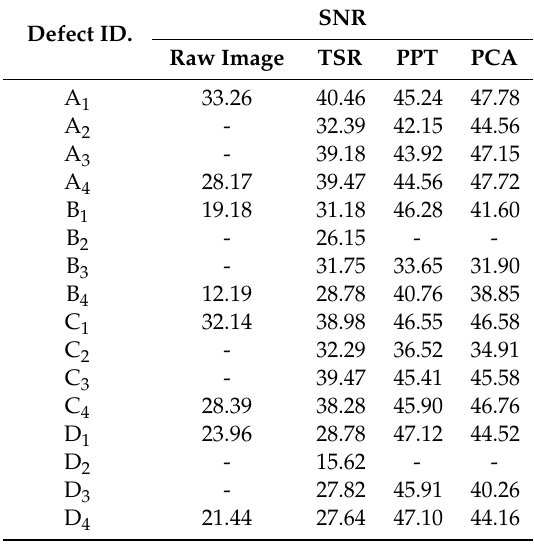
Table 2. SNR values for each processing techniques and flat-bottomed holes. Defect